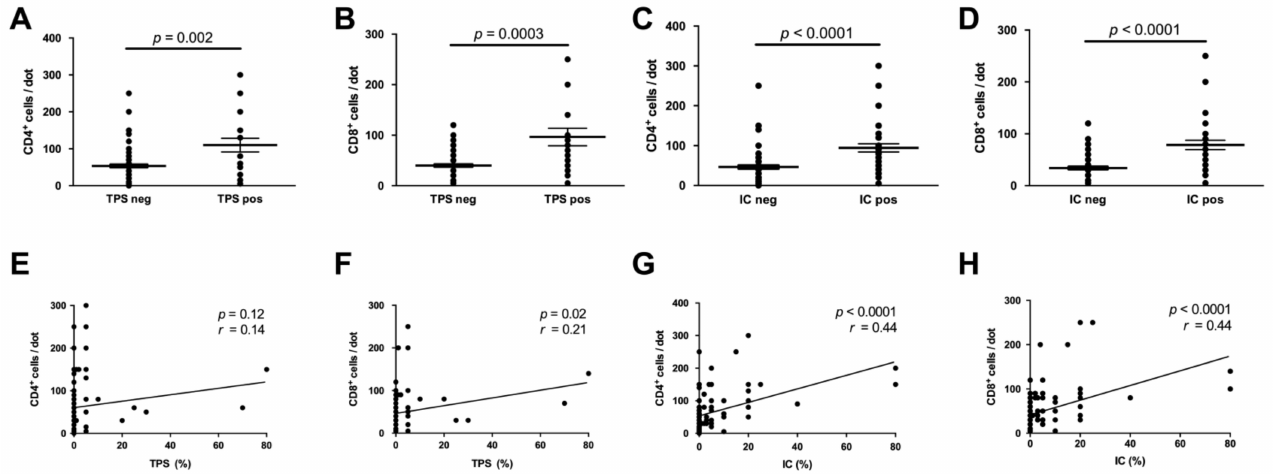
Figure 4. PD-L1 expression is associated with immune cell phenotype and density. Cases with positive PD-L1 expression either in tumor (Tumor Proportion Score (TPS), ( A , B ) or immune cells (Immune Cell Score) (IC), ( C , D ) displayed significantly increased intra- and peritumoral CD4 + - and CD8 + -immune cell densities. Correlation analysis confirmed this association, reaching significance for the correlation of the TPS with CD8 + -cell density and for the correlation of the IC with CD4 + - /CD8 + -cell density ( E – H